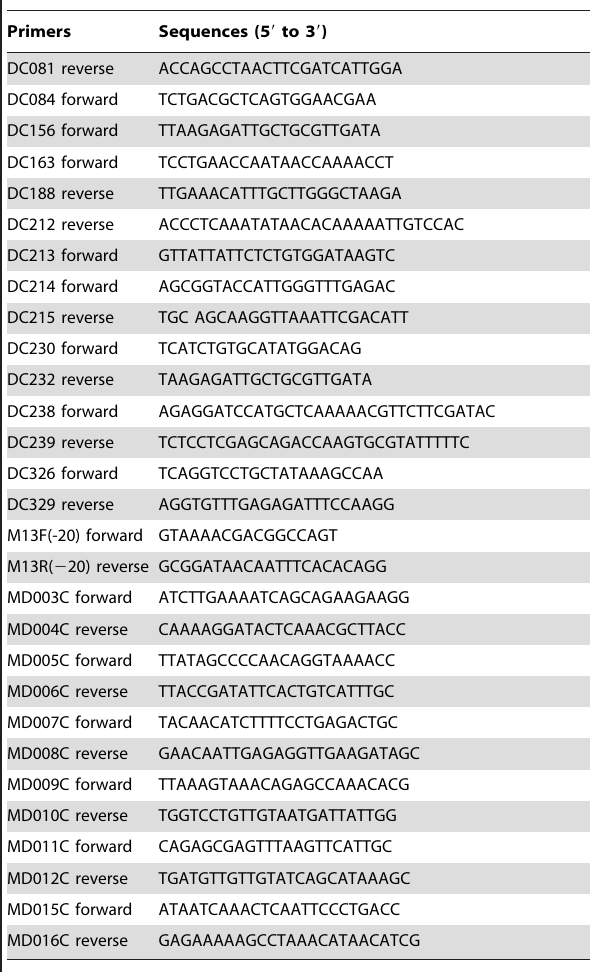
Table 3. Primers used in this